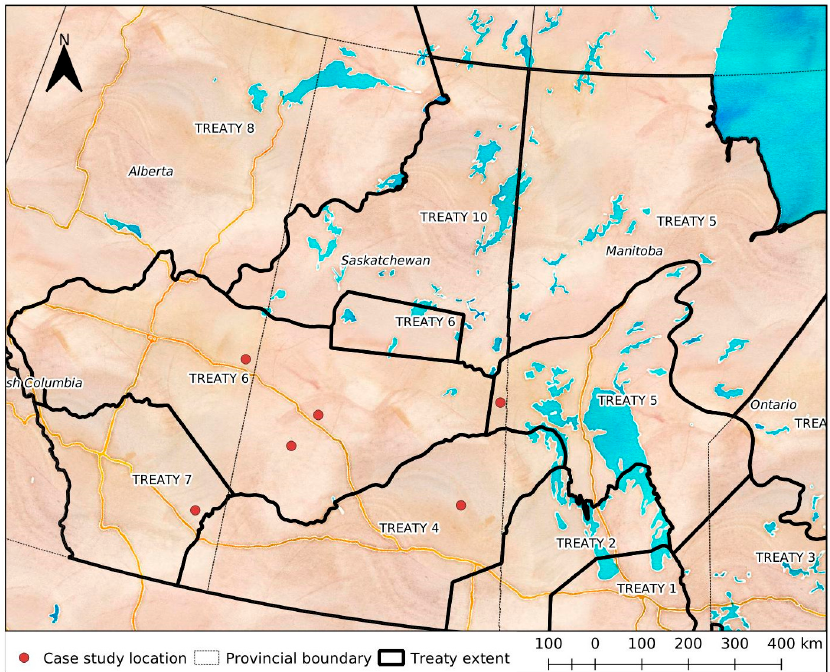
Figure 1. Approximate study locations. Sources: Global Forest Watch Canada (treaty), Natural Resources Canada (provinces).